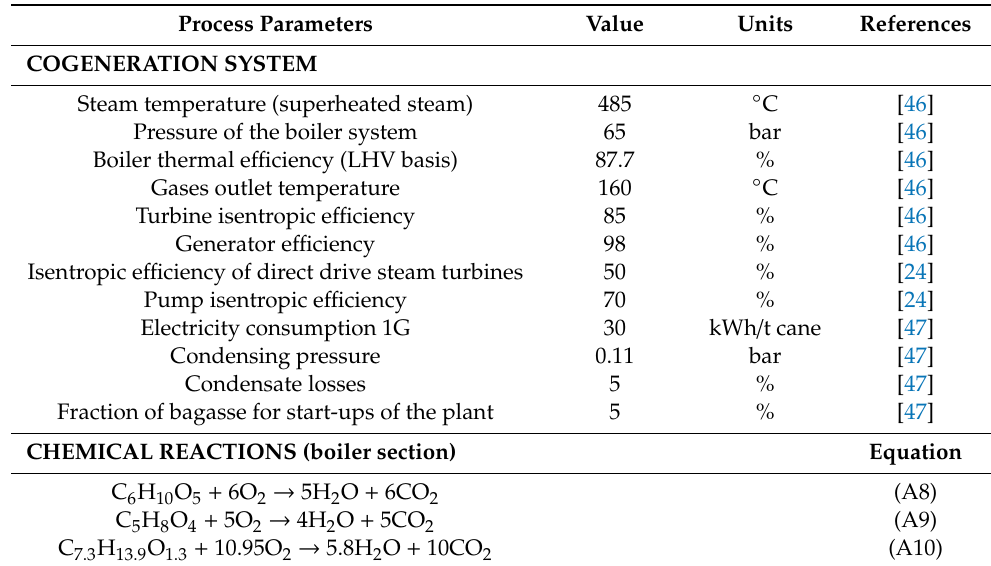
Table A6. Combined heat and power unit.